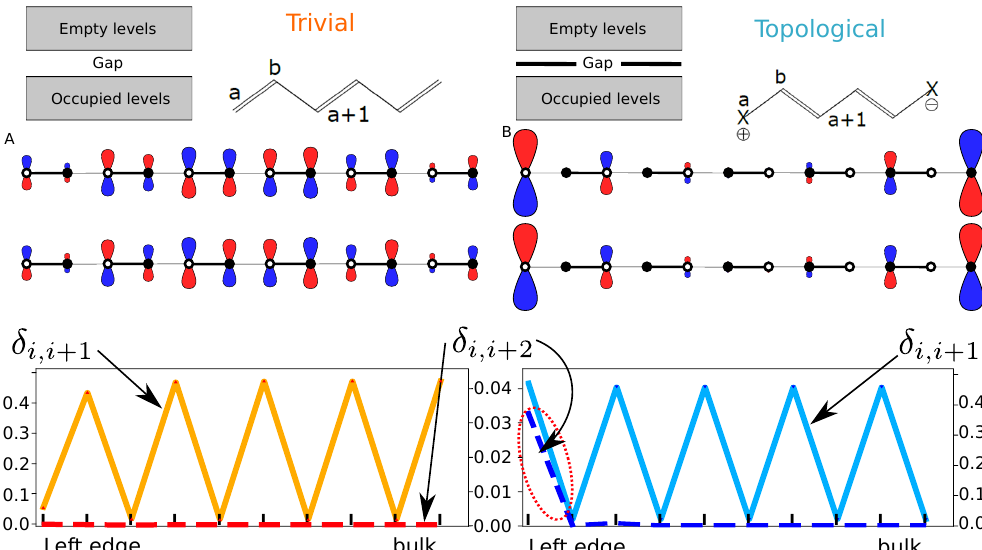
Figure 5. Energy levels, resonance scheme, orbitals around the Fermi level and DIs δ i , i + 1 and δ i , i + 2 of the bipartite lattice. The trivial phase (in red and orange, β = 3 and β (cid:48) = 1) and the topological phase (in blue and ligth blue, β = 1 and β (cid:48) = 3) are shown. The DIs have different scale, but the 0 coincides in all curves. Only 10 values of the DIs are shown, starting from an edge. The other edge is exactly symmetric to the one